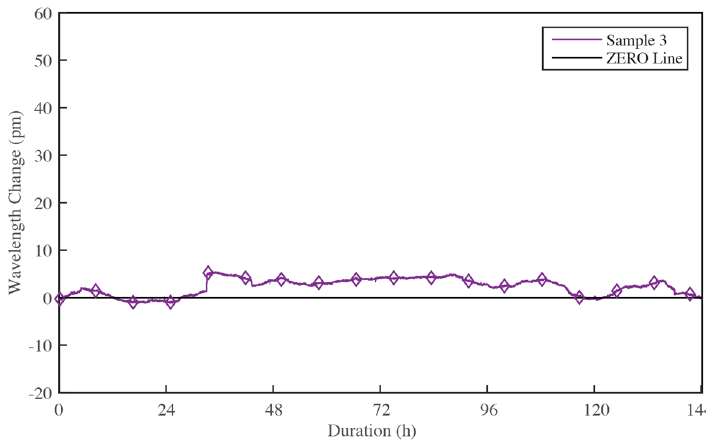
Figure 21. Bragg wavelength change of Sample #3 with no corrosion on top of sensor.